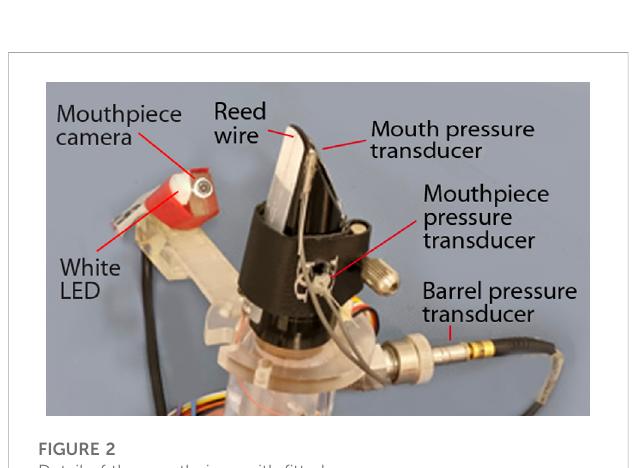
FIGURE 2 Detail of the mouthpiece with fi tted